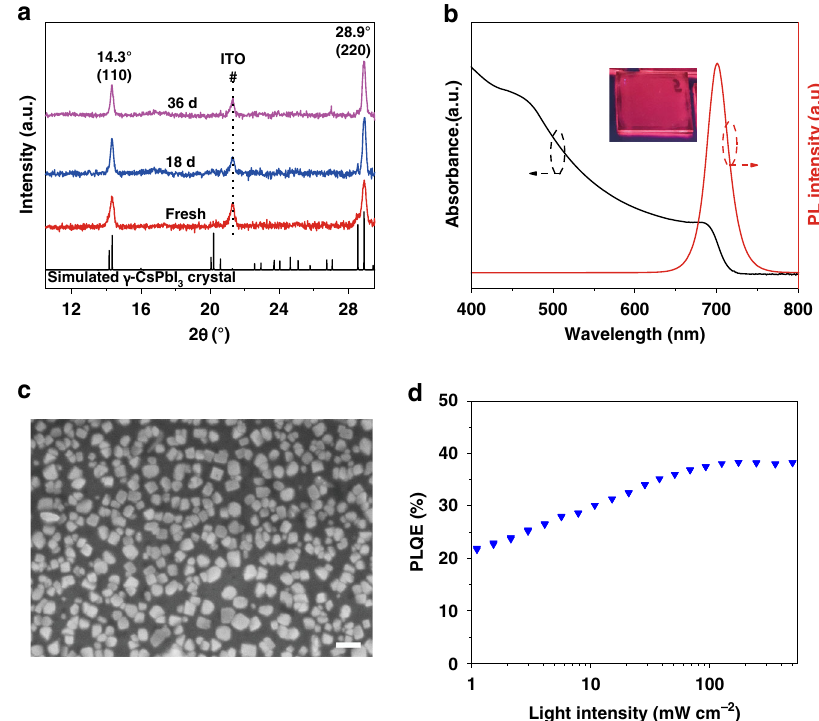
Fig. 1 Characteristics of IZI-CsPbI 3 fi lm on ZnO/PEIE substrate. a XRD pattern after exposed in the air with 80% relative humidity for various durations. Black line is the simulated powder patterns of γ -CsPbI 3 8 . b UV – vis and PL spectrum. Inset shows the image under UV light. c SEM image (scale bar, 200 nm), and d Excitation-intensity-dependent